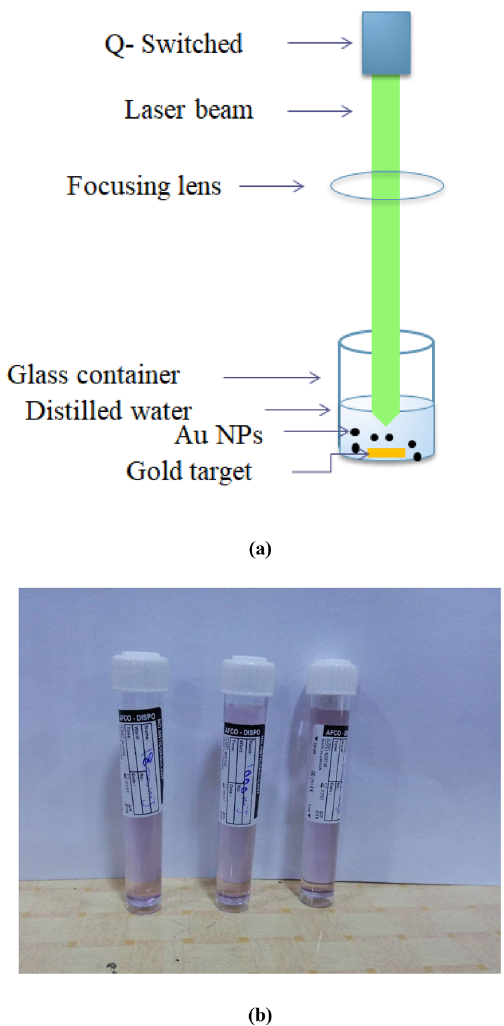
Figure 3. Presents: ( a ) a schematic of the PLA technique used to prepare the Au NPs, and ( b ) the prepared Au NPs at the three ablated